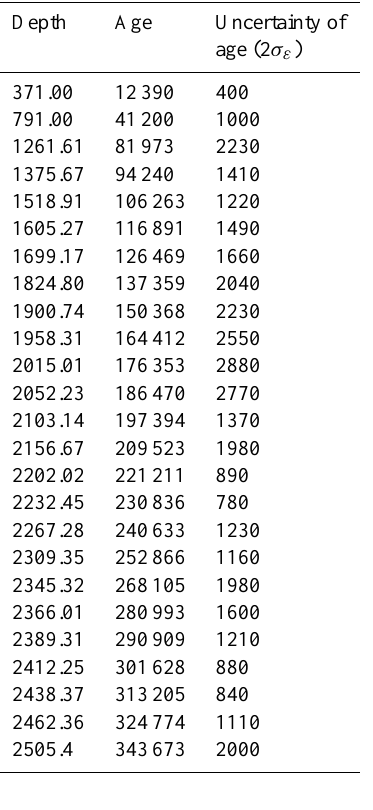
Table 1. Depth, age, and uncertainty of age at each tie point.